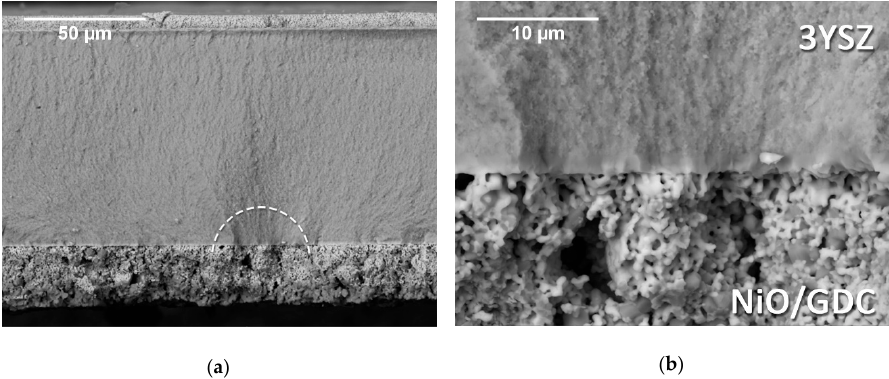
Figure 10. ( a ) Example of the fracture surface appearance of a SOC2 specimen tested with the fuel electrode on the tensile side of loading; fracture. ( b ) Detail of the fracture initiation area.